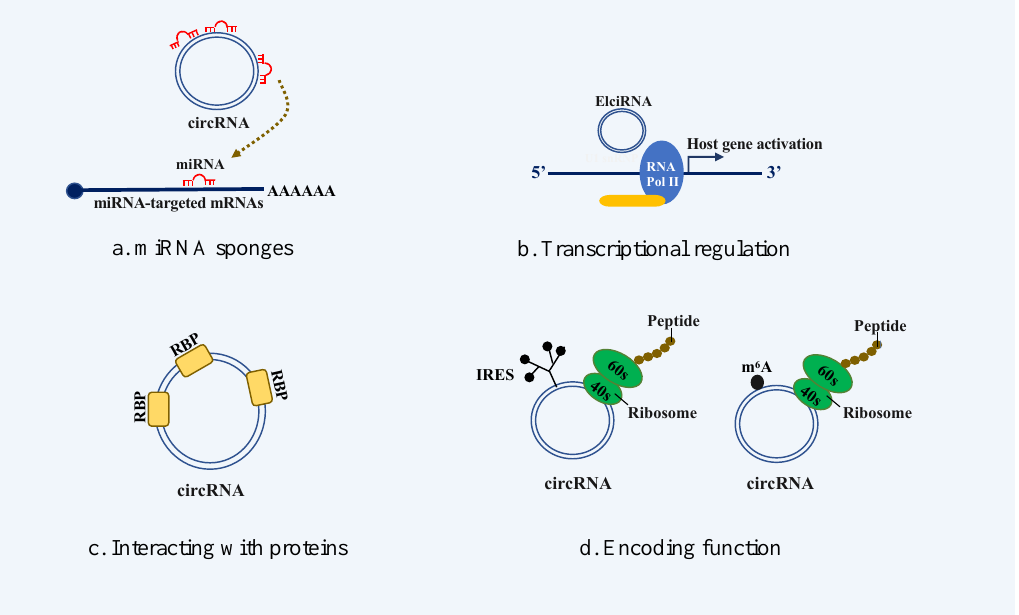
Figure 1. Biological functions of circRNAs. ( a ) circRNAs can function as ceRNA by reducing the expression of mRNAs targeting miRNAs. ( b ) elciRNAs affect the host gene expression by interacting with RNA polymerase II (RNA Pol II) with small nuclear ribonucleoprotein U1 (U1 snRNP) in the nucleus. ( c ) The interactions between circRNAs and RNA binding proteins (RBPs) can modulate these proteins functions. ( d ) Some circRNAs might translate ribosomes in an internal ribosome entry site (IRES)- and 5 ′ UTR N 6 -methyladenosine (m 6 A)-mediated translation initiation.